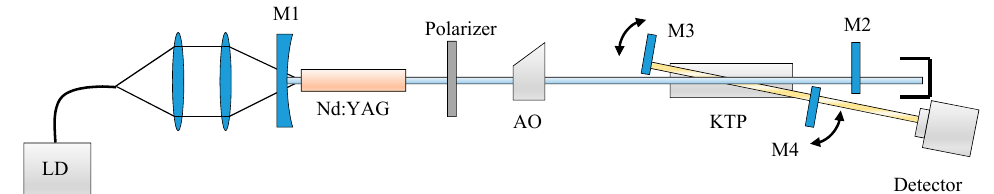
Figure 1. Optical scheme of the Q-switched intracavity SPS-SRS laser based on KTP. LD: laser diode;